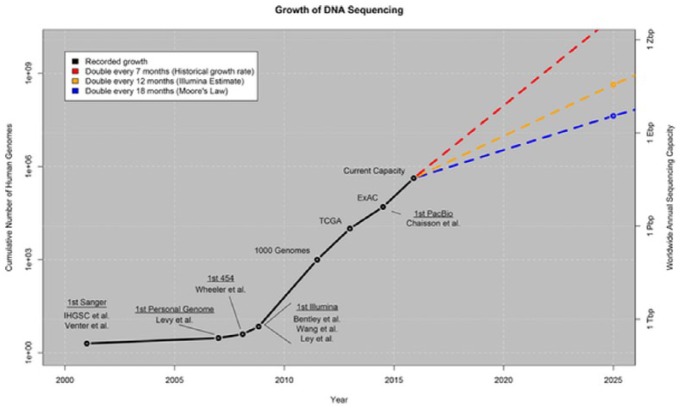
Growth of DNA sequencing (Stephens et al., 2015).